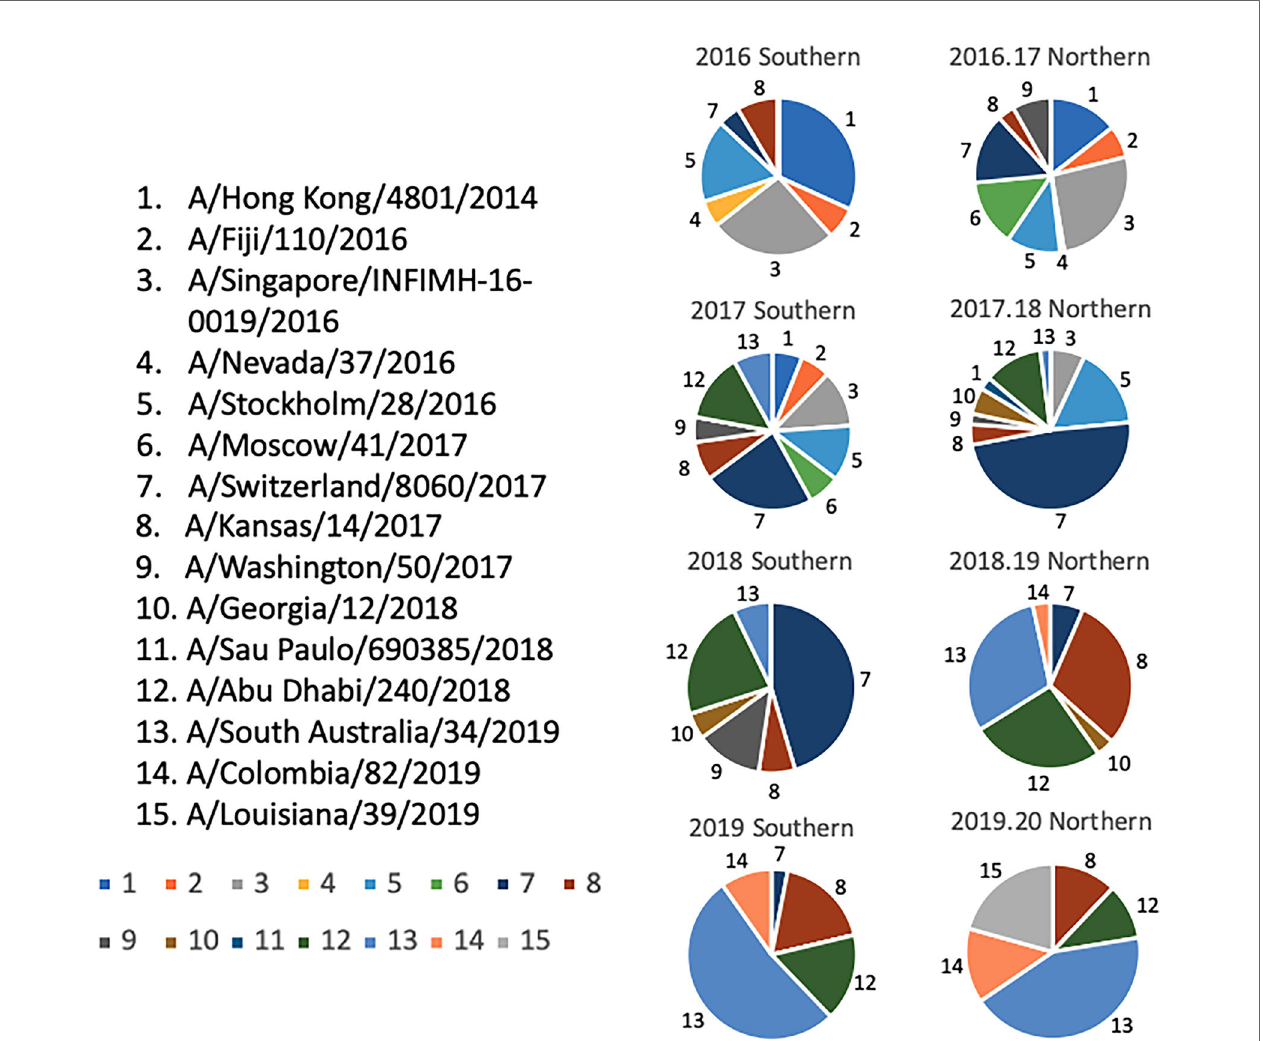
FIGURE 5 | Determination of Co-circulating H3N2 Strains 2016-2020. Relative frequencies of in fl uenza HA clusters from co-circulating H3N2 strains in consecutive seasons from 2016-2020. In fl uenza HA sequences were obtained from the GISAID database, aligned, and clustered into families for each representative Northern and Southern Hemisphere in fl uenza season timeframe. The HA sequences from each season were then divided into clusters based on a 95% sequence similarity cutoff, and are depicted by a different color and slice of each pie chart. A representative strain from each cluster was chosen and assigned a number 1-15. Colors assigned to each number match the color in the pie